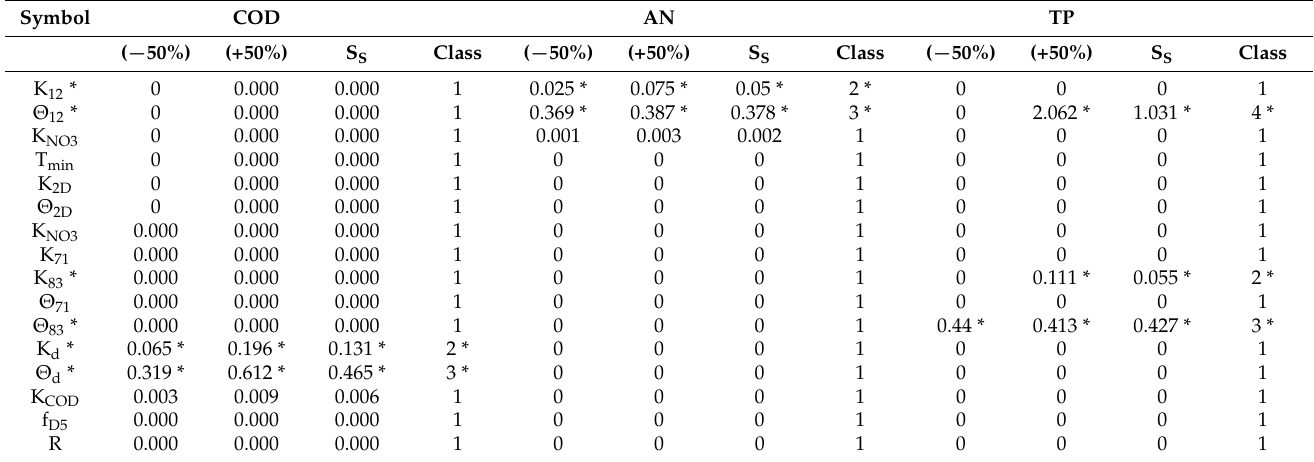
Table 10. Parameter sensitivity